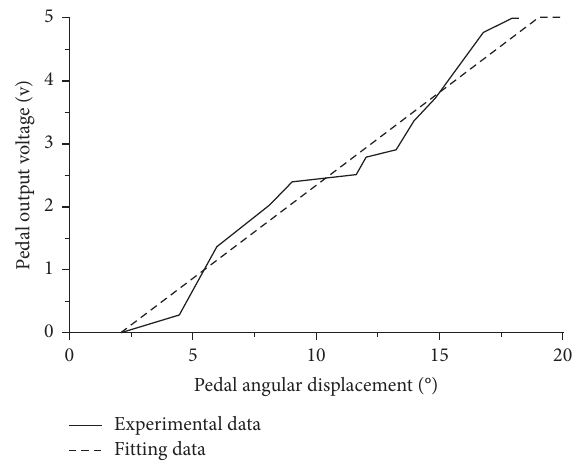
Figure 2: Fit curve of pedal angular displacement and pedal output